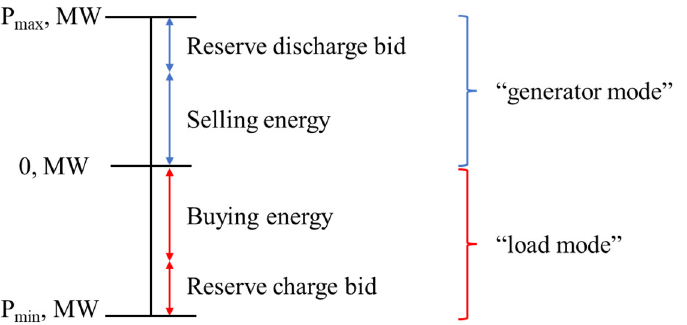
Figure 4. Bi-directional operation of BESS, with example of combined energy and reserve bids in either generator or load operating mode.